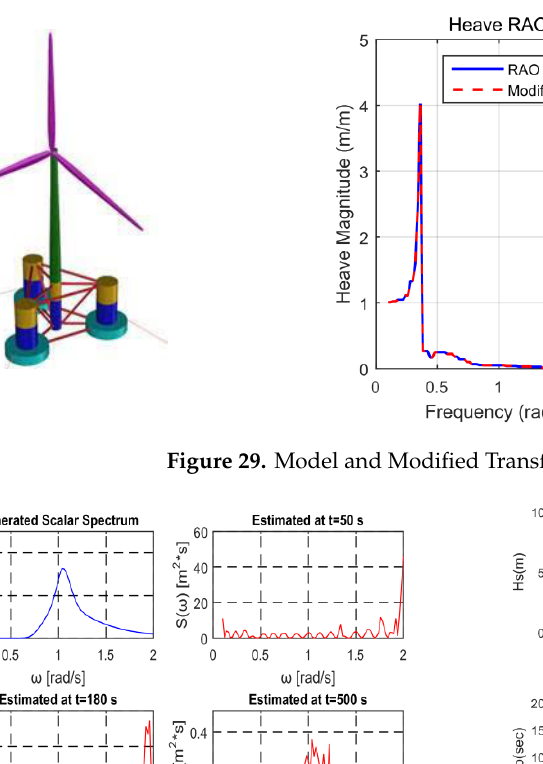
Figure 28. Generated and estimated spectrum/Evolution of parameters (Sea sate 7, Hs = 13 m, Tp = 11 s).